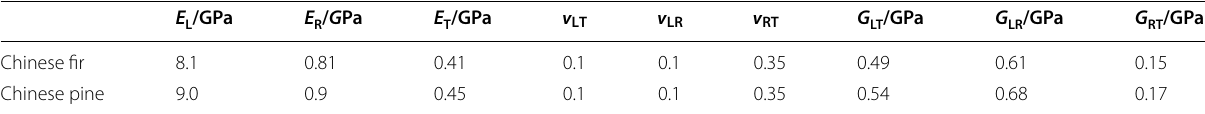
E denotes elasticity modulus, v denotes Poisson ratio, and G denotes tangential modulus. The subscript: L-longitudinal, R-radial, and T-tangential